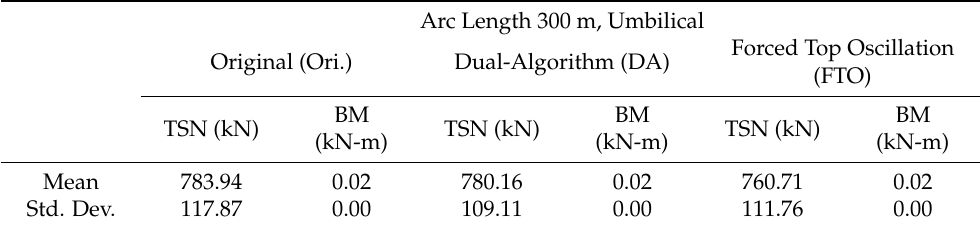
Figure A6. Node Displacement Tracing, Snapshots, 100-yr storm, WD1000, Umbilical, Entire Arc Length. Table A6. Statistical Characteristics Comparison, Original vs. Dual-Algorithm (DA) or FTO, 100-yr Storm, WD1000, Int.100 m, Umbilical. Arc Length 300 m, Umbilical Original